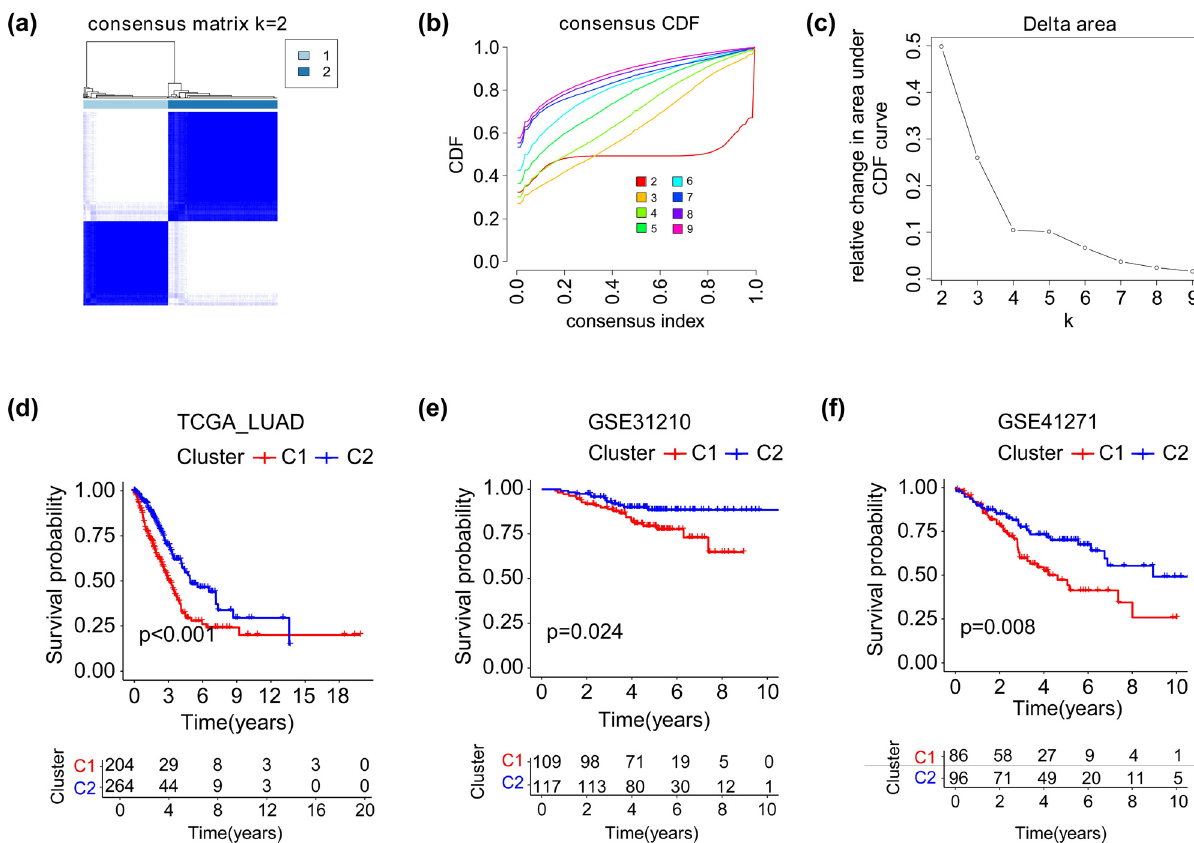
Figure 1: Classi fi cation and prognosis of LUAD according to the PRGs. ( a ) Two clusters were generated by unsupervised consensus clustering. ( b and c ) Consensus clustering cumulative distribution function ( CDF ) and relative change in area under the CDF curve ( k from 2 to 10 ) . ( d – f ) KM analysis showed that patients in the C2 cluster had a longer OS in the TCGA_LUAD ( d ) , GSE31210 ( e ) , and GSE41271 ( f )